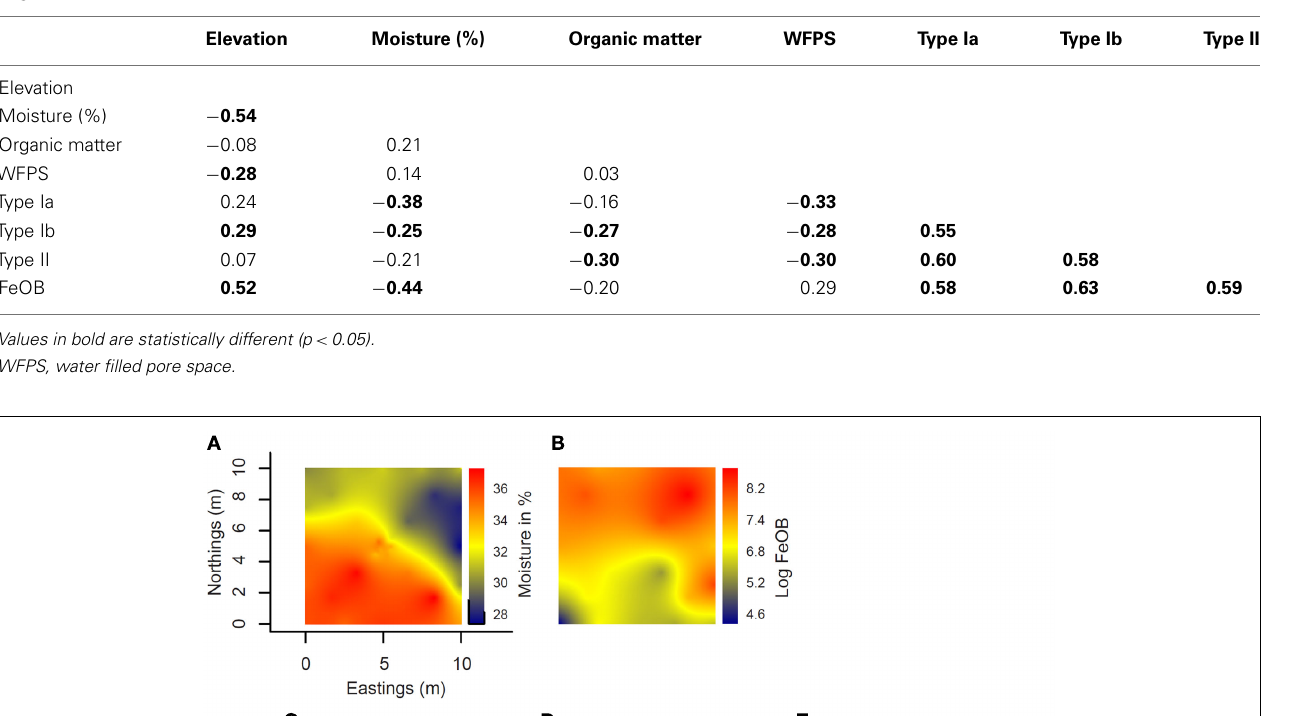
Table 2 | Spearman rank correlation table of measured environmental parameters and gene copy numbers of Ga-FeOB and type Ia, Ib, and II MOB.